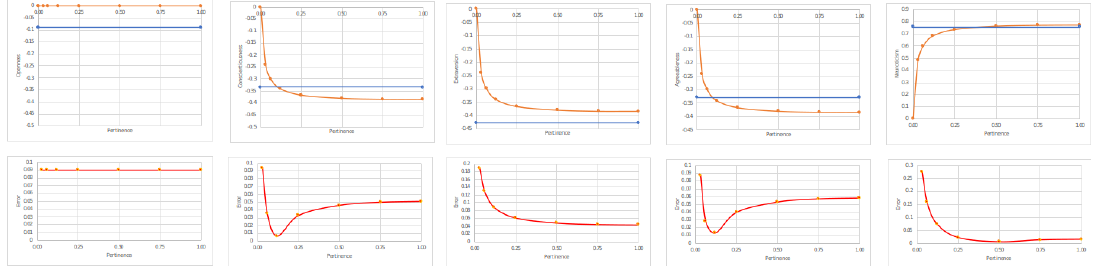
Figure 12. Error graphics from Fear input emotion—OCEANS’s